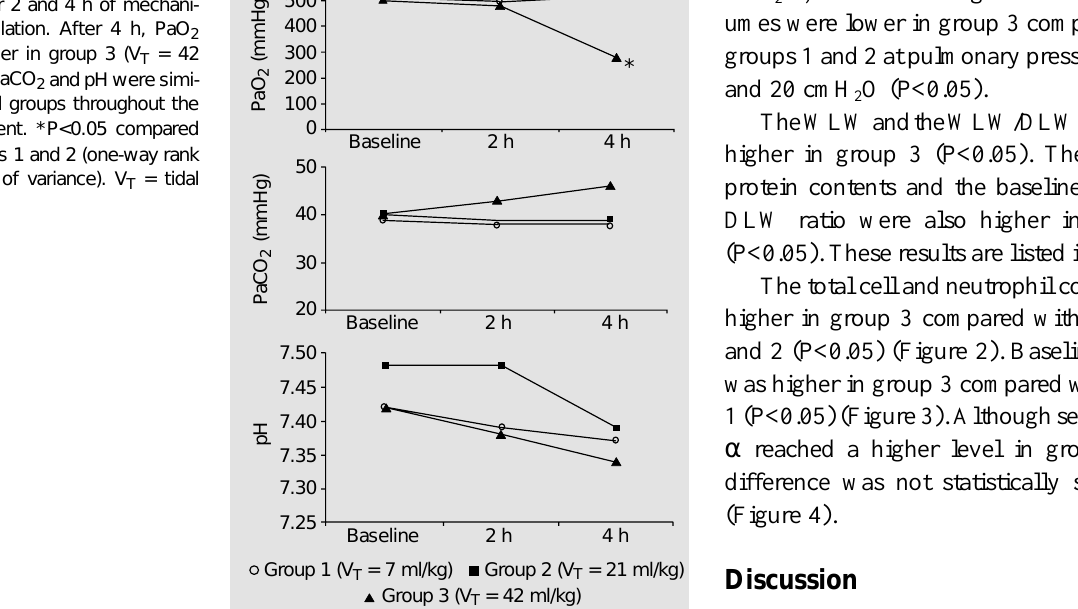
Figure 1. PaO 2 , PaCO 2 , and pH in the three groups at baseline and after 2 and 4 h of mechani- cal ventilation. After 4 h, PaO 2 was lower in group 3 (V T = 42 ml/kg). PaCO 2 and pH were simi- lar for all groups throughout the experiment. *P<0.05 compared to groups 1 and 2 (one-way rank analysis of variance). V T = tidal volume.